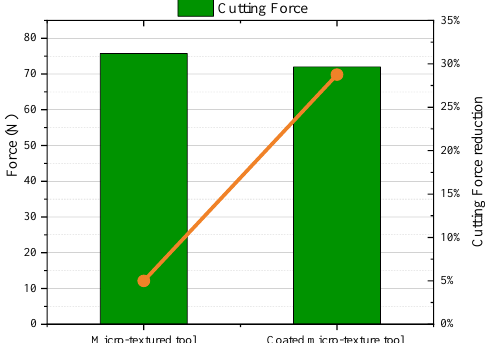
Figure 15. Comparison of cutting force of coated and uncoated tools.